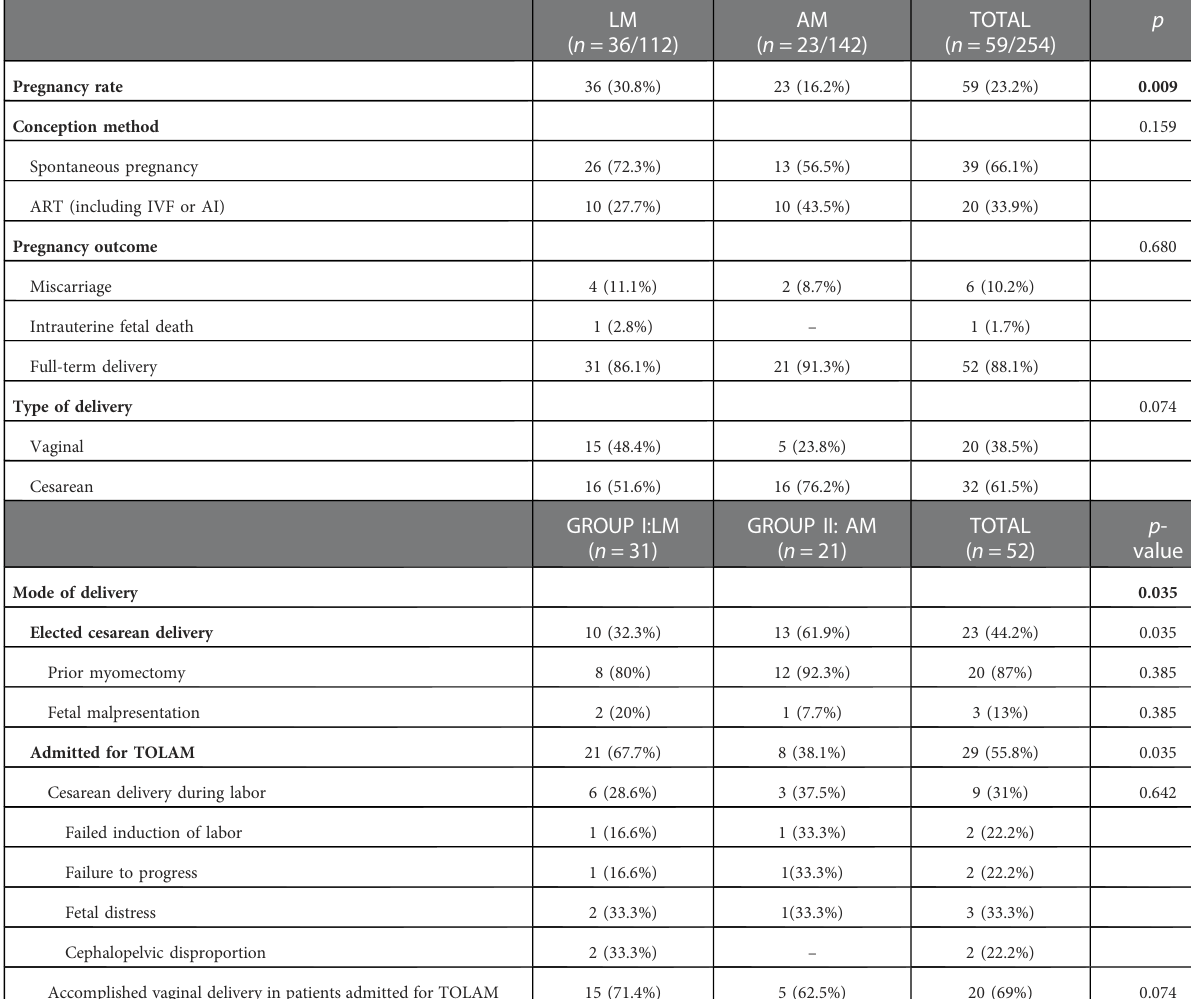
TABLE 3 Obstetrics and delivery outcomes according surgical